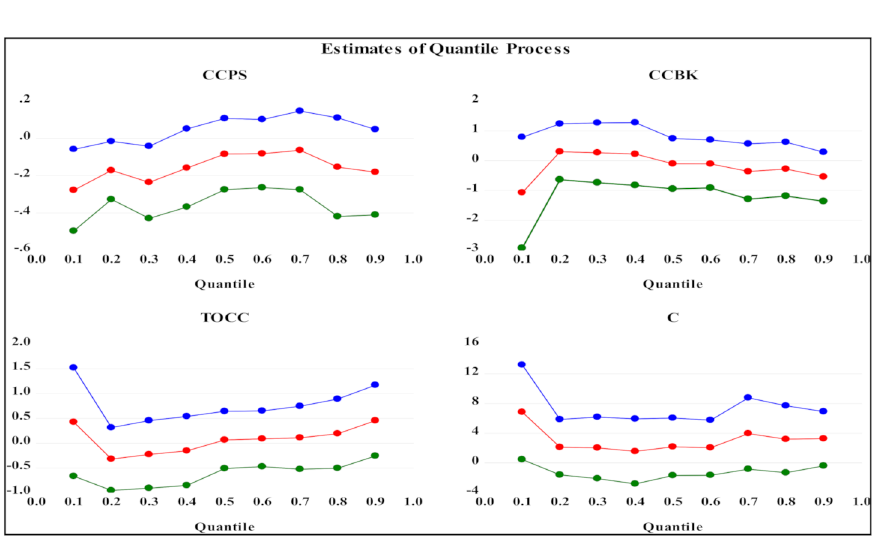
Figure 2. Plot of the quantile process estimates.